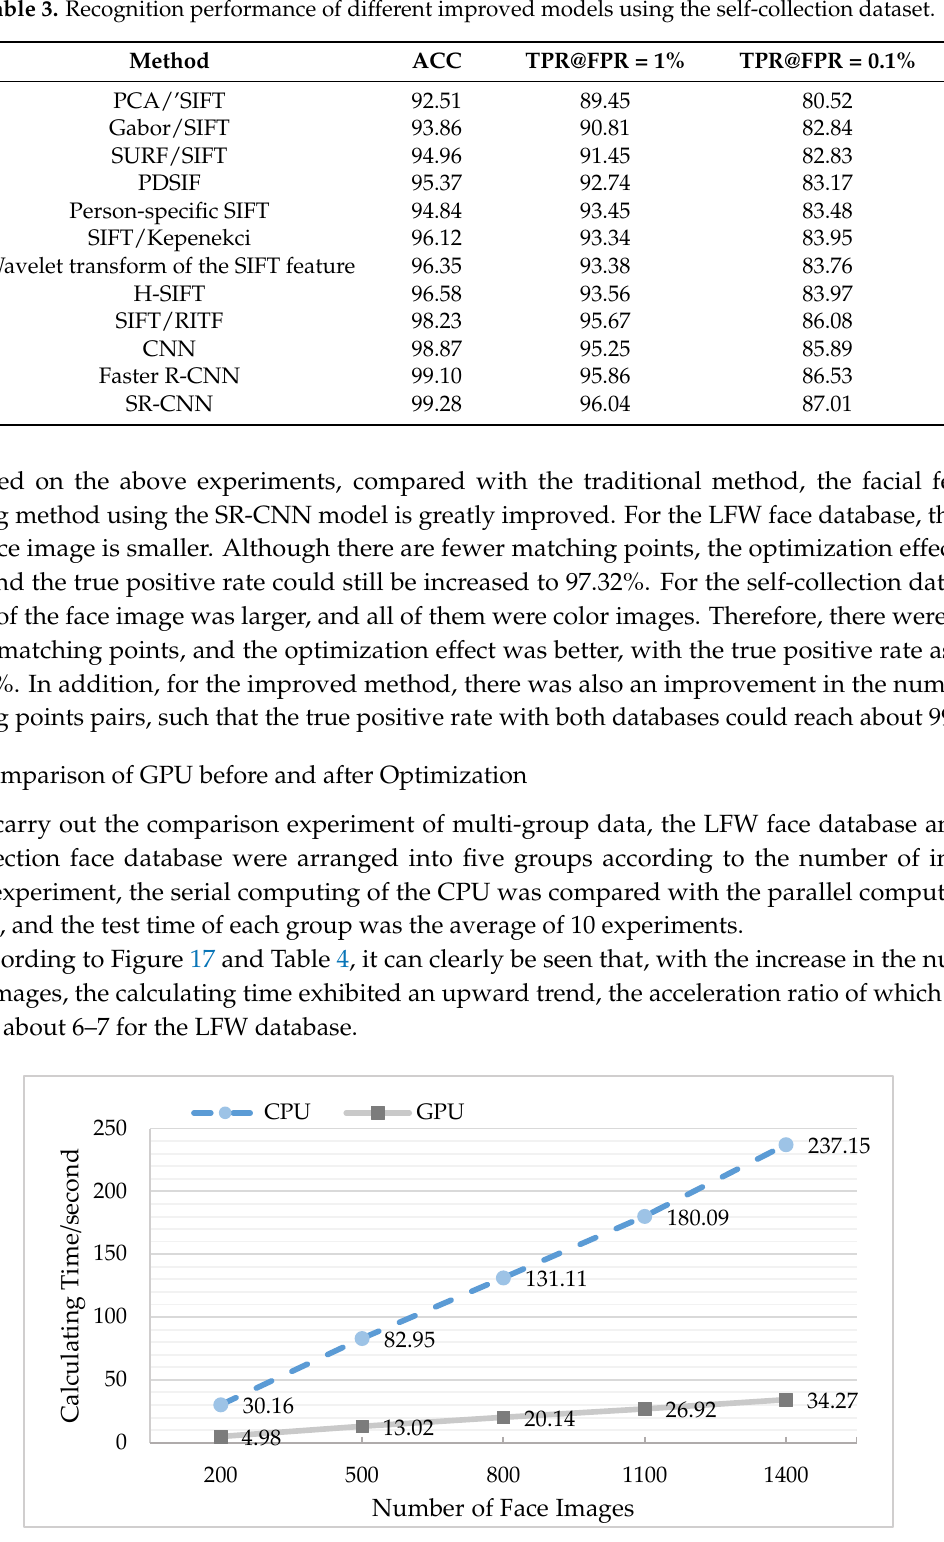
Figure 17. Comparison of central processing unit (CPU) and graphics processing unit (GPU) operation time (using the LFW database). Table 4. Acceleration ratios of central processing unit (CPU) and graphics processing unit (GPU) using the LFW face database.